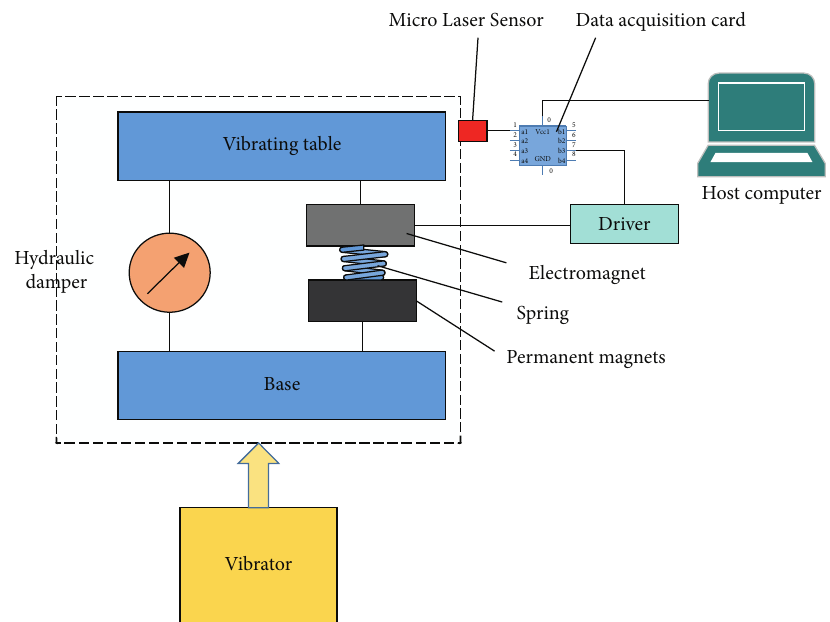
Figure 11: Principle of the hardware system.